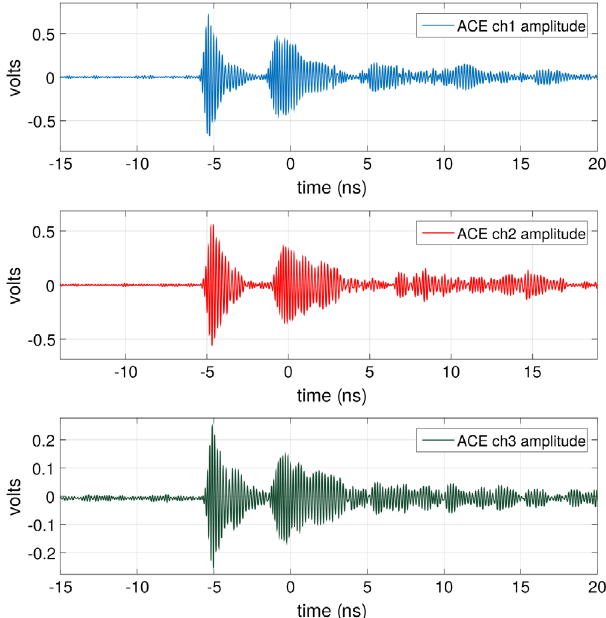
FIG. 10. Average microwave signals for 12.16 GeV showers in ACE, for 67 events of higher SNR. The detector for this run is operating with a full set of tungsten preshower blocks, at liquid nitrogen temperature, with all low-noise amplifiers installed. The figure scales for each subplot are set in the relative ratios of ( 6 . 1 ∶ 4 . 9 ∶ 2 . 0 ) based on the GEANT excess-charge ratios to illustrate that the amplitude closely scales with these